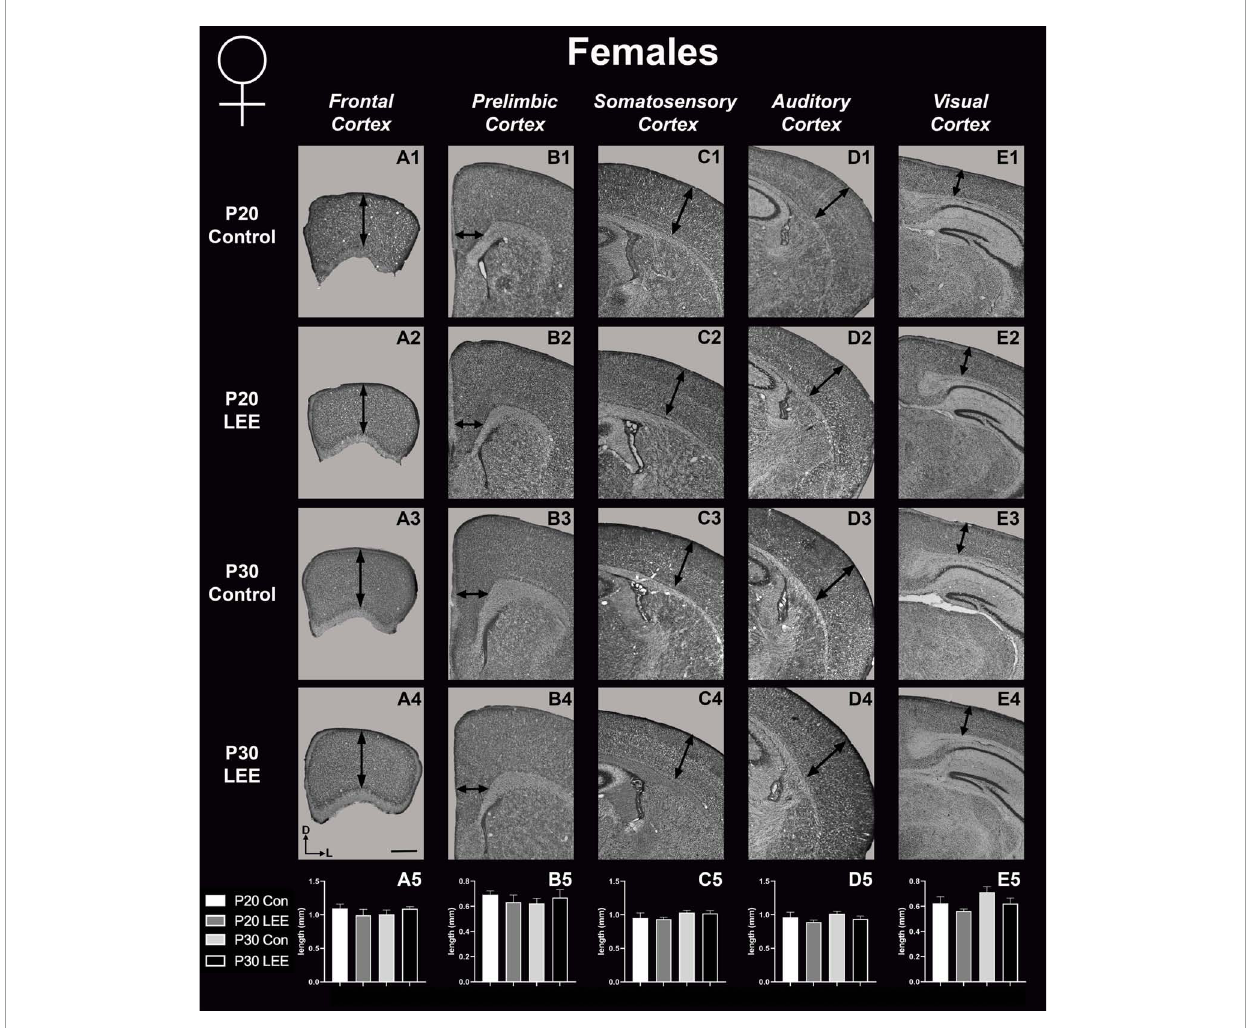
FIGURE7 Cortical thickness measurements – females. High magnification coronal sections of Nissl-stained hemisections. Measurements include frontal cortex ( A1–A5 ; N = 19), prelimbic cortex ( B1–B5 ; N = 11), somatosensory cortex ( C1–C5 ; N = 26), auditory cortex ( D1–D5 ; N = 20), and visual cortex ( E1–E5 ; N = 20). No significant differences between control and LEE pups. Data expressed as mean ± SEM. Images oriented dorsal (D) up and lateral (L) to the right. Scale bar, 1